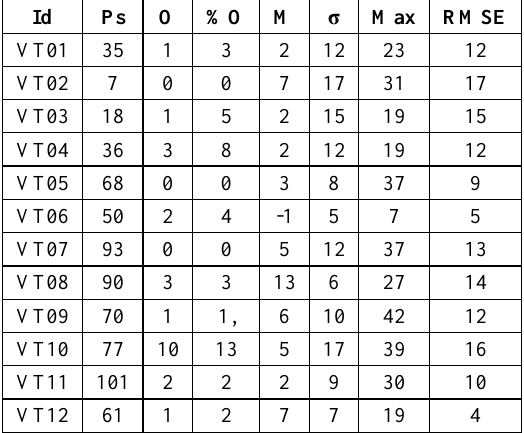
Table 6. Statistics of first campaign. Id, Number of RTK Points, Number of Outliers, Percentage of Outliers, Mean, Standard deviation, Absolute Maximum value, Root Mean Square Error. All metric results in